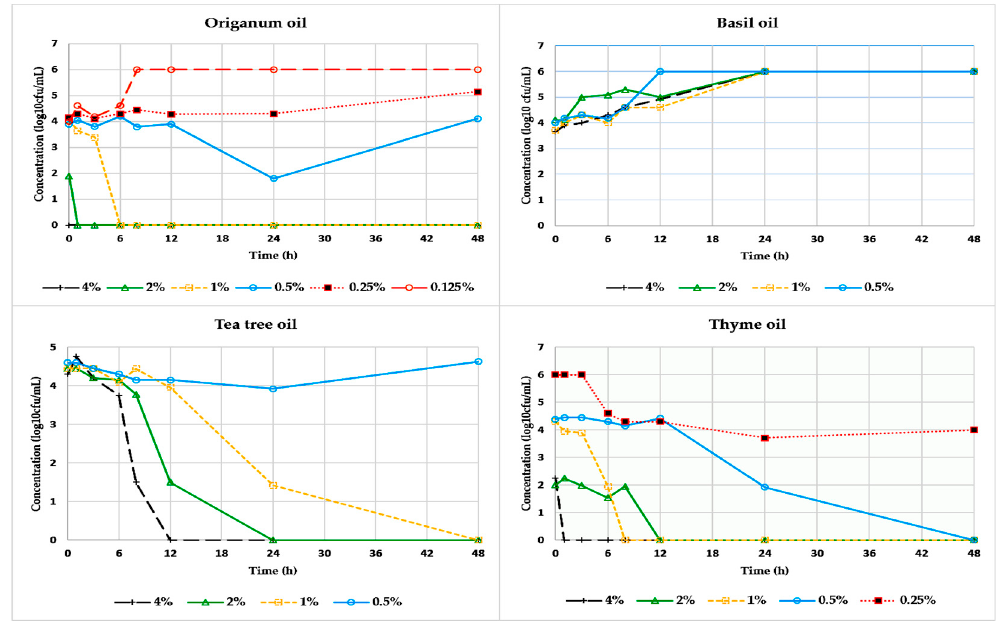
Figure 2. Time-kill kinetics for origanum oil, basil oil, tea tree oil, and thyme oil on a vancomycin resistant E. faecium (VRE no. 2) clinical isolate (isolated from wound swab). Appl. Sci. 2018 , 8 , x FOR PEER REVIEW